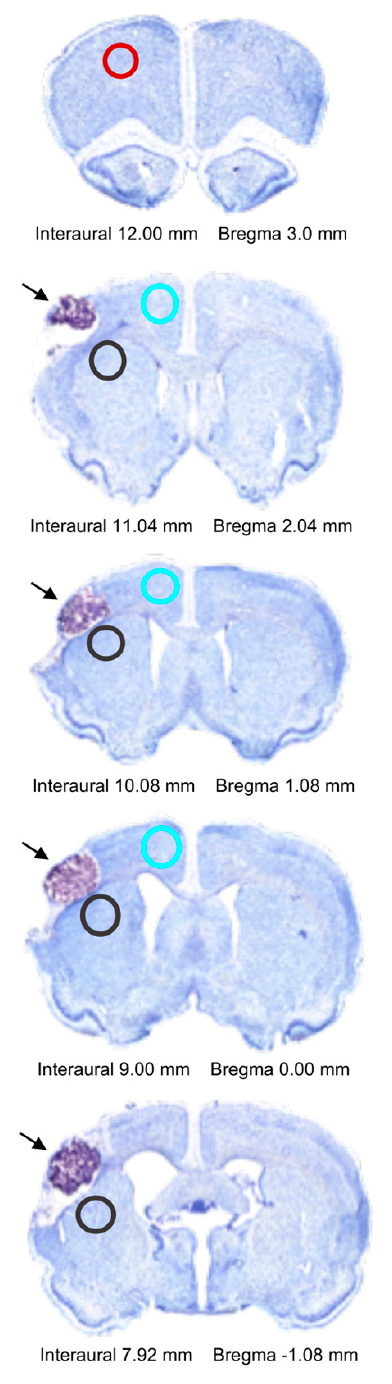
Figure A1. Photomicrographs of cresyl violet-stained brain sections containing hydrogel implants (arrows) at 5 × magnification. ROIs for immunohistochemistry analysis are indicated by circles. Red = anterior motor cortex, black = corpus striatum, blue = cingulate cortex.